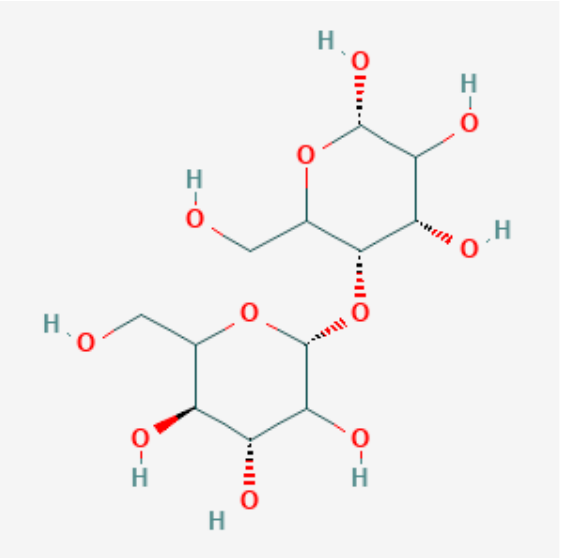
Figure 6. Molecular structure of starch soluble [126] . (Starch is a polysaccharide mainly found in plant cells.)